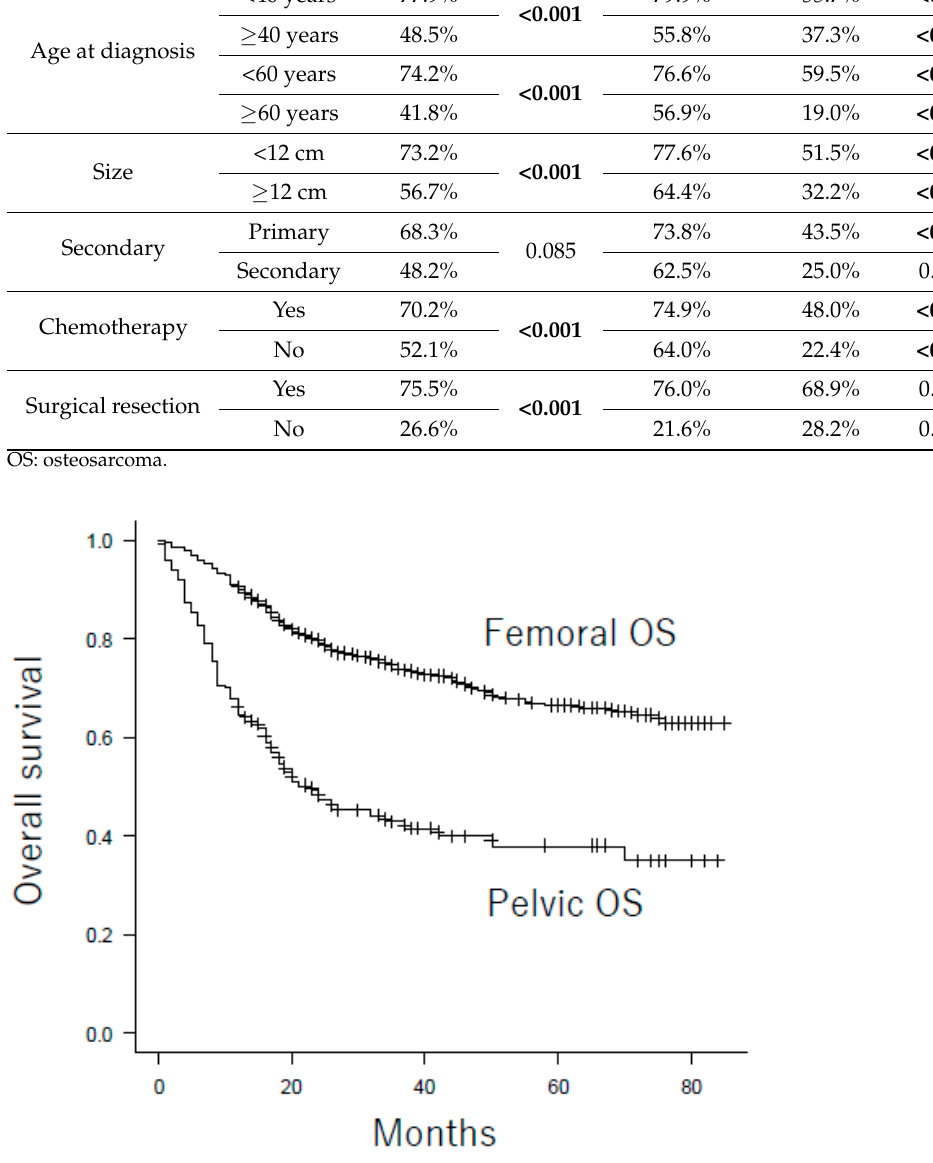
Figure 1. Overall survival for patients with pelvic osteosarcoma and femoral osteosarcoma. The 3-year overall survival rates were 42.8% in pelvic osteosarcoma and 73.7% in femoral osteosarcoma ( p < 0.001). OS: osteosarcoma. Table 3. Multivariate Cox Hazard models for overall survival of the patients with femoral and pelvic osteosarcoma.